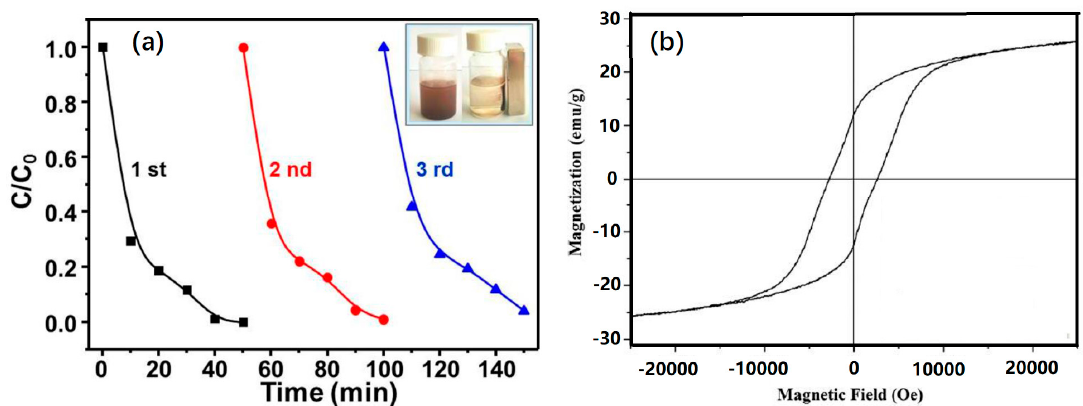
Figure 12. ( a ) Recyclability of NiO-NiFe 2 O 4 -rGO to activate PMS; ( b ) The magnetic hysteresis loops of NiO-NiFe 2 O 4 -rGO magnetic nanomaterials.